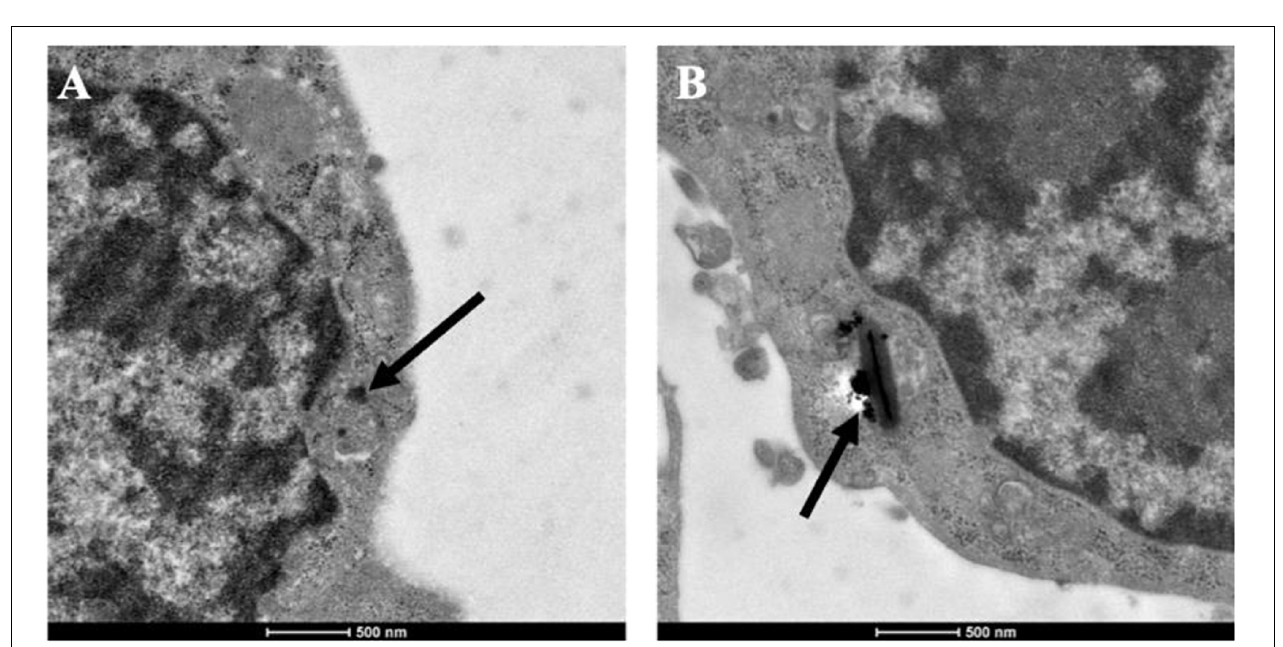
FIGURE 1 | Characterization of CuBiS 2 NPs. (A) XRD pattern and the corresponding standard pattern of CuBiS 2 NPs. (B) SEM images of CuBiS 2 NPs, Scale bars: 2 µ m; (C) UV-vis-NIR absorption spectrum of CuBiS 2 NPs.